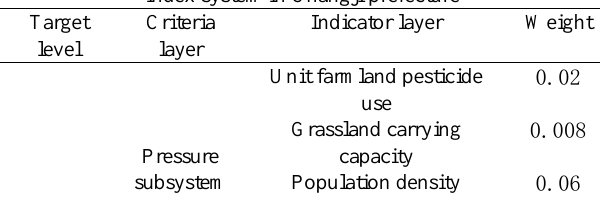
Table 1. Standard and weight of grassland health assessment